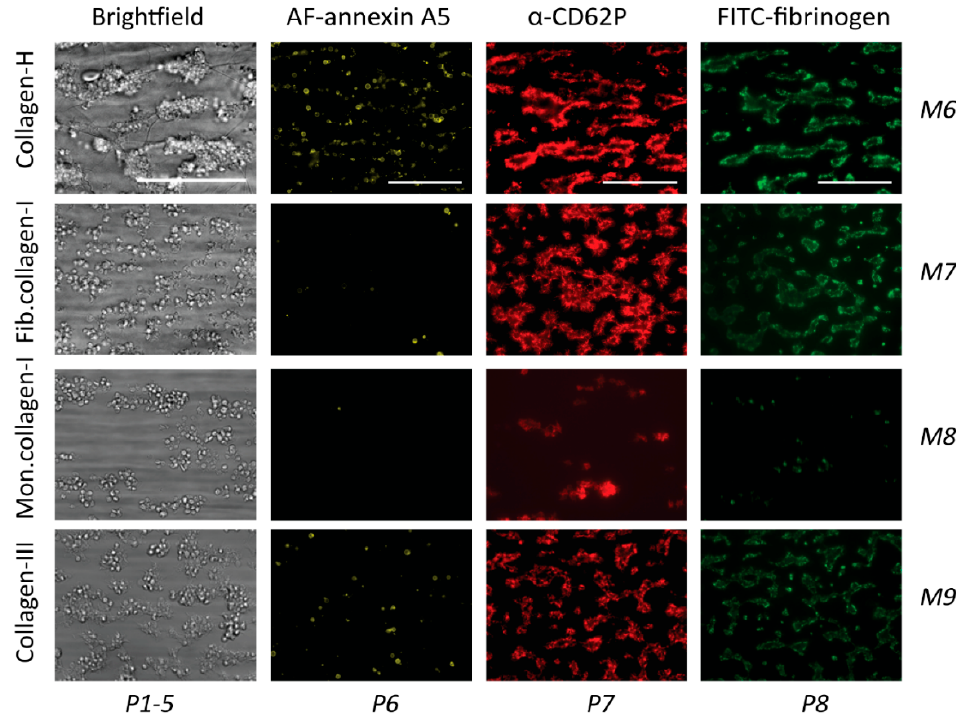
Figure 5. Thrombus formation on immobilized collagens. Whole blood was perfused over microspots M6 (collagen-H), M7 (fibrillar collagen-I), M8 (degraded collagen-I), and M9 (collagen-III). The wall-shear rate was 1000 s − 1 , and the perfusion time was 3.5 min. Representative bright-field microscopic images at the end stage are shown for an analysis of platelet deposition (parameter P1) and thrombus characteristics (P2–5). In addition, end-stage three-color fluorescence images for an analysis of PS exposure (AF568 annexin A5, P6), CD62P expression (AF647 α -CD62P, P7), and fibrinogen binding (FITC, P8) are shown. Scale bars represent 50 µm.